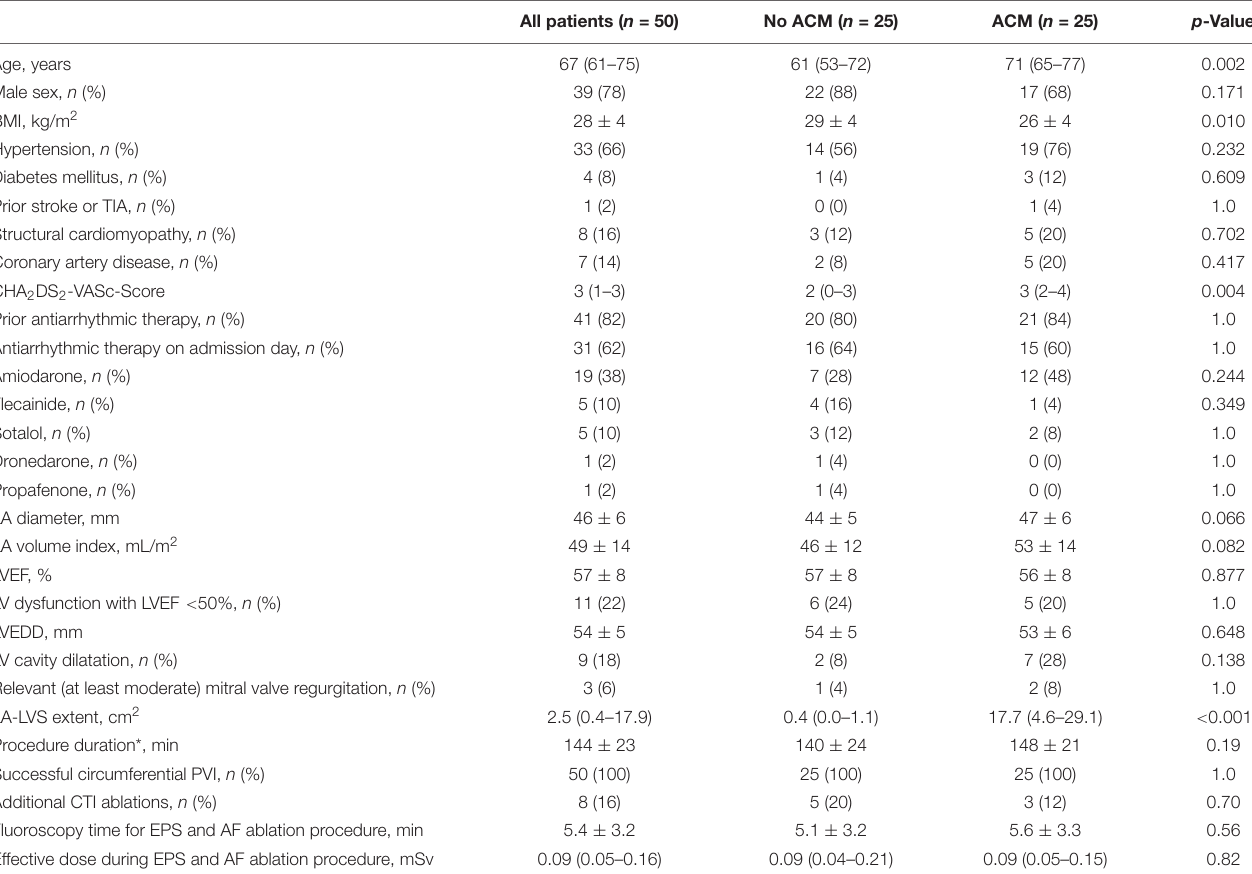
TABLE 1 | Clinical and procedural characteristics.